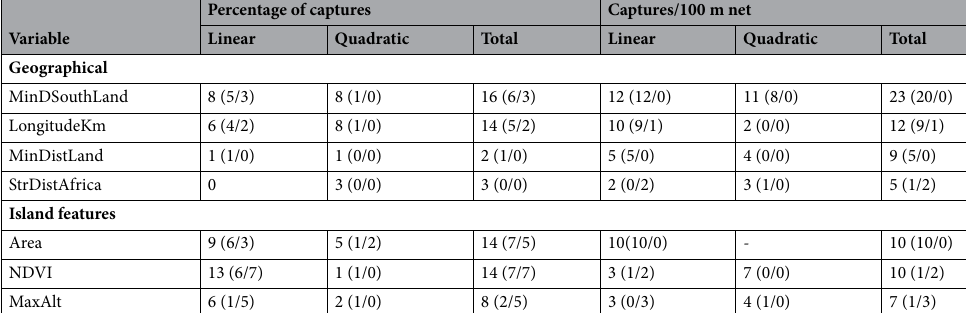
Table 6. Number of species with a significant model relating the percentage of total captures or the average daily number of captures per 100 m of mist net to island descriptors. In the captures/100 m net models, Columbrets Island is not included. Linear models and models with a quadratic term were tested. In parentheses the number of models with a positive (left) or negative (right) effect of each variable. The difference between the sum of numbers in parentheses and the total is due to models in which the maximum of captures occurs at intermediate values of the predictor variable.